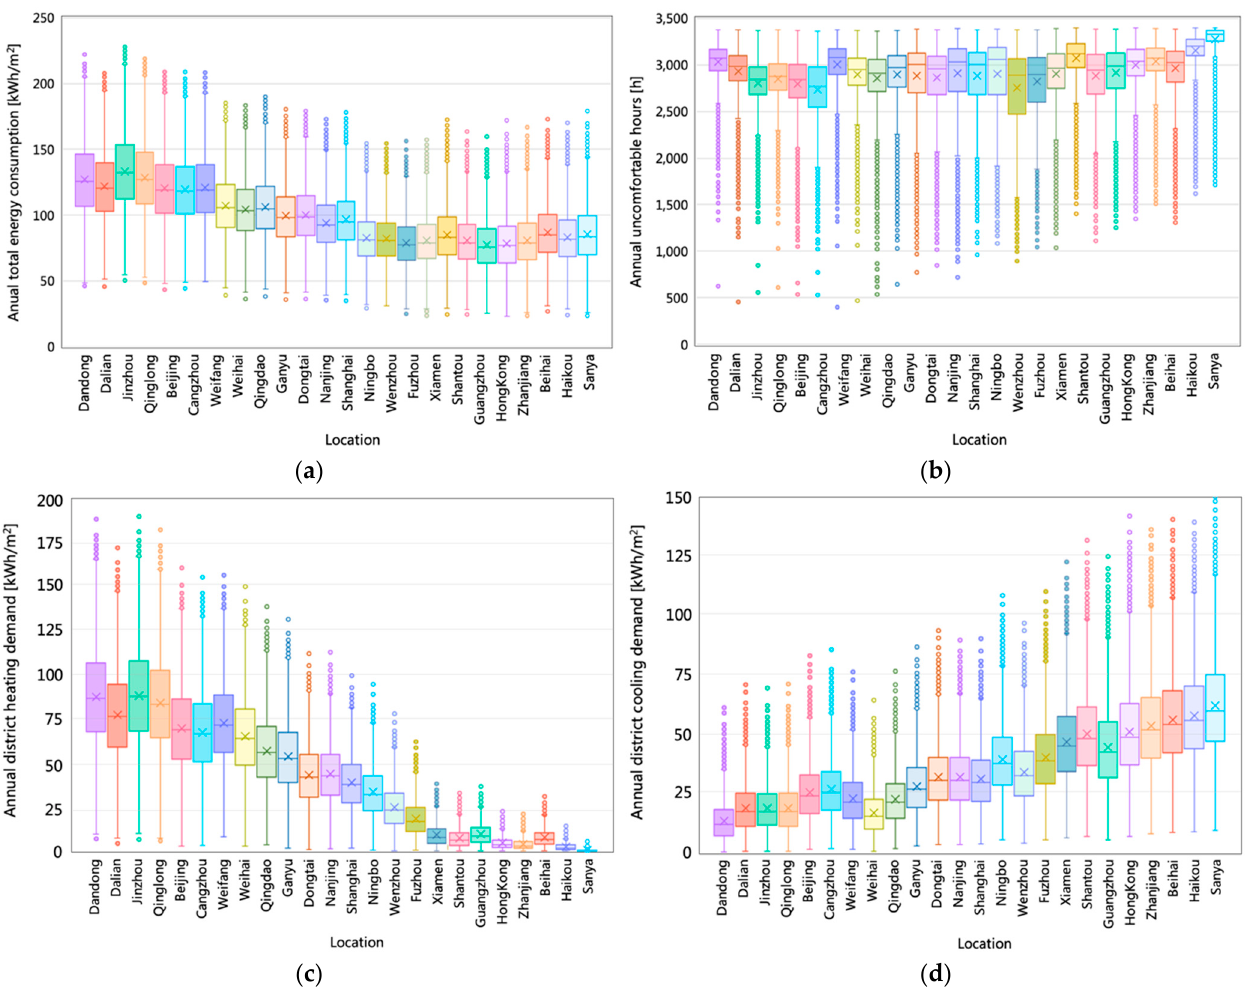
Figure 6. Simulation results of the building in 24 coastal cities: ( a ) annual total building energy consumption; ( b ) IUH; ( c ) district heating demand; ( d ) district cooling demand.